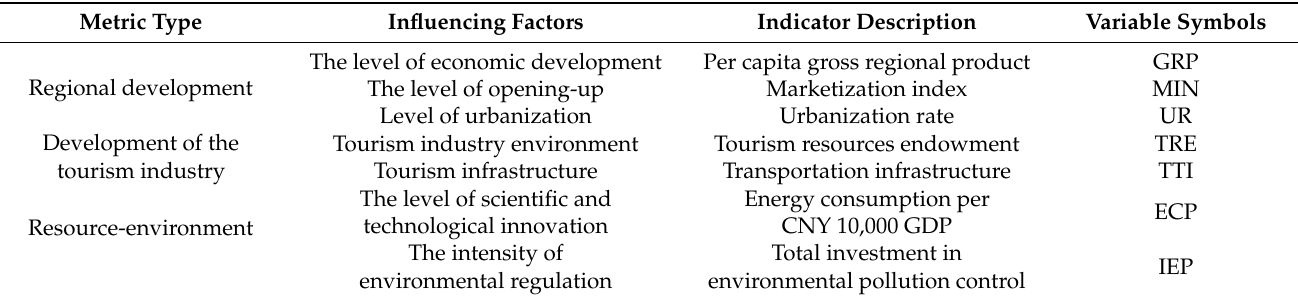
Table 1. Illustration of the influencing factor indices of tourism carbon emissions